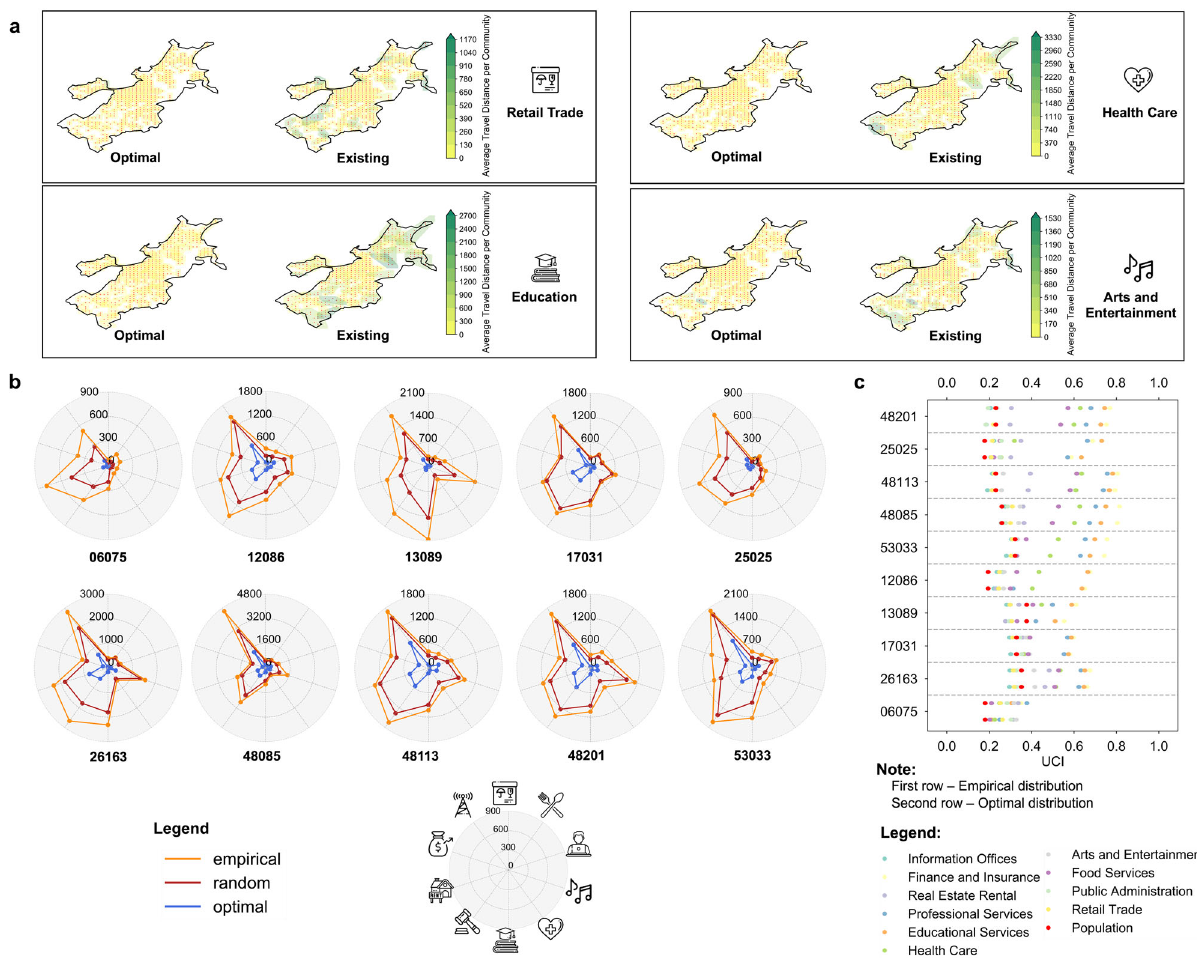
Fig. 3 The optimal distribution of facilities and the resulted travel costs (distances). a Service communities of different types of facilities in the existing and optimal scenarios in Suffolk County. The dots represent residential grid cells, and the areas are the service communities. Due to a limited number of facilities in some areas, the people living in grid cells of some service communities have to travel for a long distance to access certain facilities. Hence, some communities are in darker green. The results for the rest of the facilities and counties are provided in Supplementary Fig. 10. b The average travel costs in optimal, existing, and random scenarios for ten types of facilities in ten counties. The numbers on each circle on the charts represent the travel costs (in meters). c The UCIs of the spatial distributions of facilities and population in counties. The fi rst row of dots for each county represents the UCIs of the existing facility distribution, and the second row of the dots for each county represents the UCIs of the optimal facility distribution. The numeric values of UCIs are provided in Supplementary Table